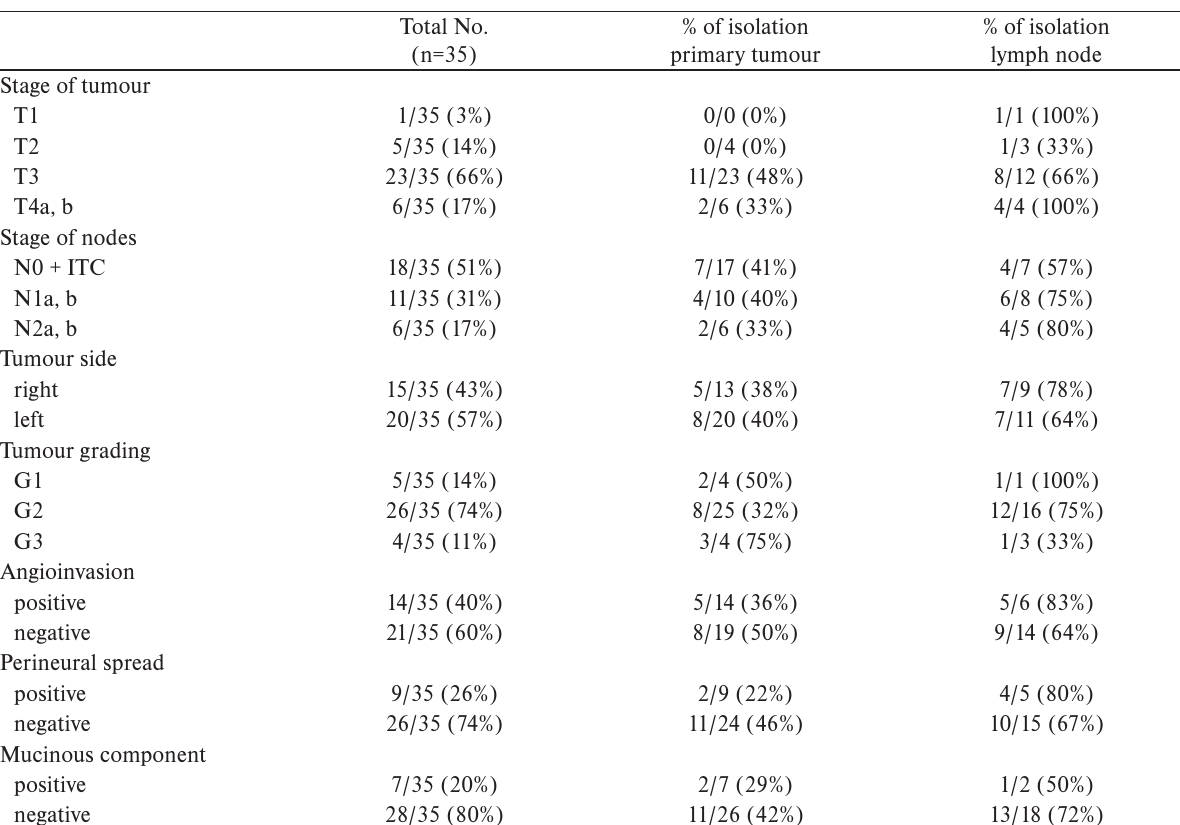
Table 1. Characteristics of primary colon cancer and respective lymph node metastasis according to the percentage of succesful isolation of corresponding cancer cells.